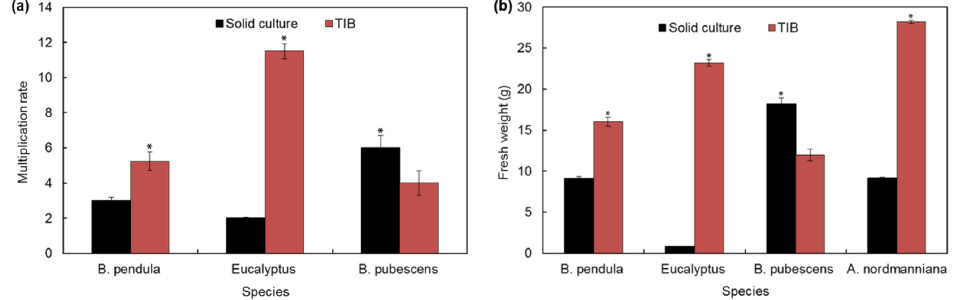
Figure 2. Effect of the TIB and solid culture medium on multiplication rate ( a ) and fresh weight ( b ). The data represents mean values ± SEM. Each treatment comprised of three culture vessels.